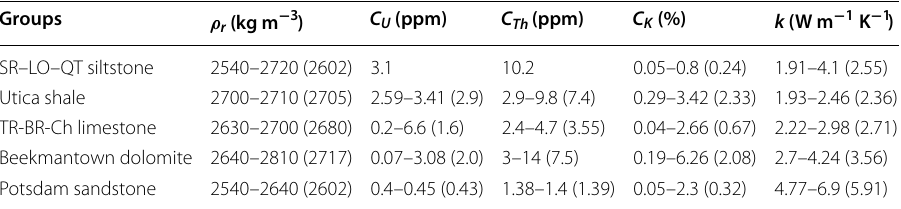
Table 1 Density, concentration of radiogenic elements, and thermal conductivity of sedimentary rocks of the St. Lawrence Lowlands, with the minimum, maximum values and average in